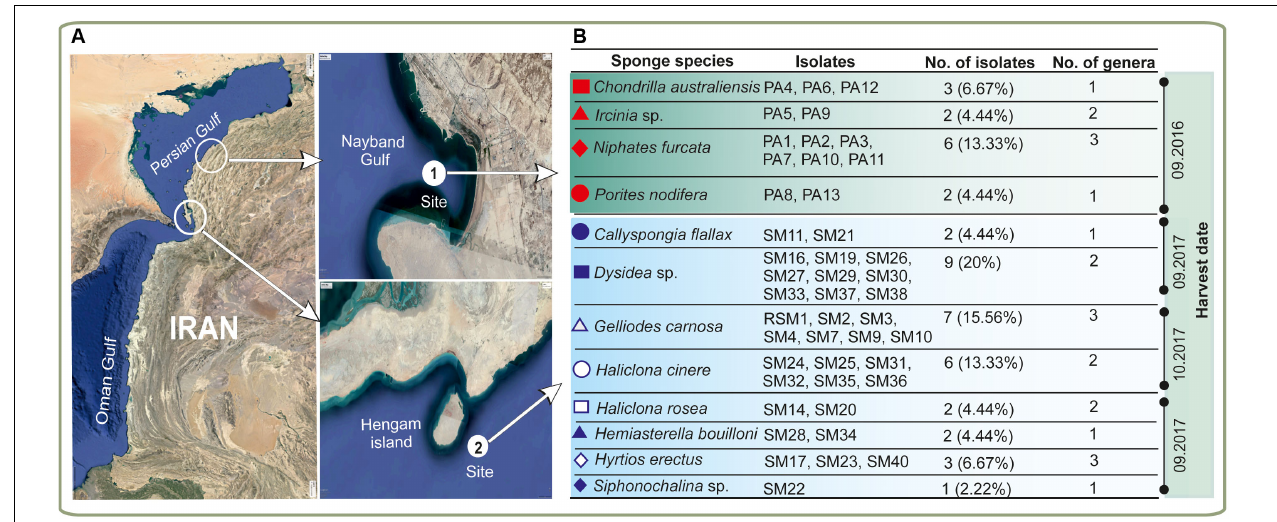
FIGURE 1 | Isolation of sponge-associated actinomycetes. (A) Geographical locations of the sampling sites with (B) representation of the diversity of the sponge material and actinomycete isolates utilized in this study. The different sponge species are indicated with red and blue symbols. Harvesting of the samples was done in three different